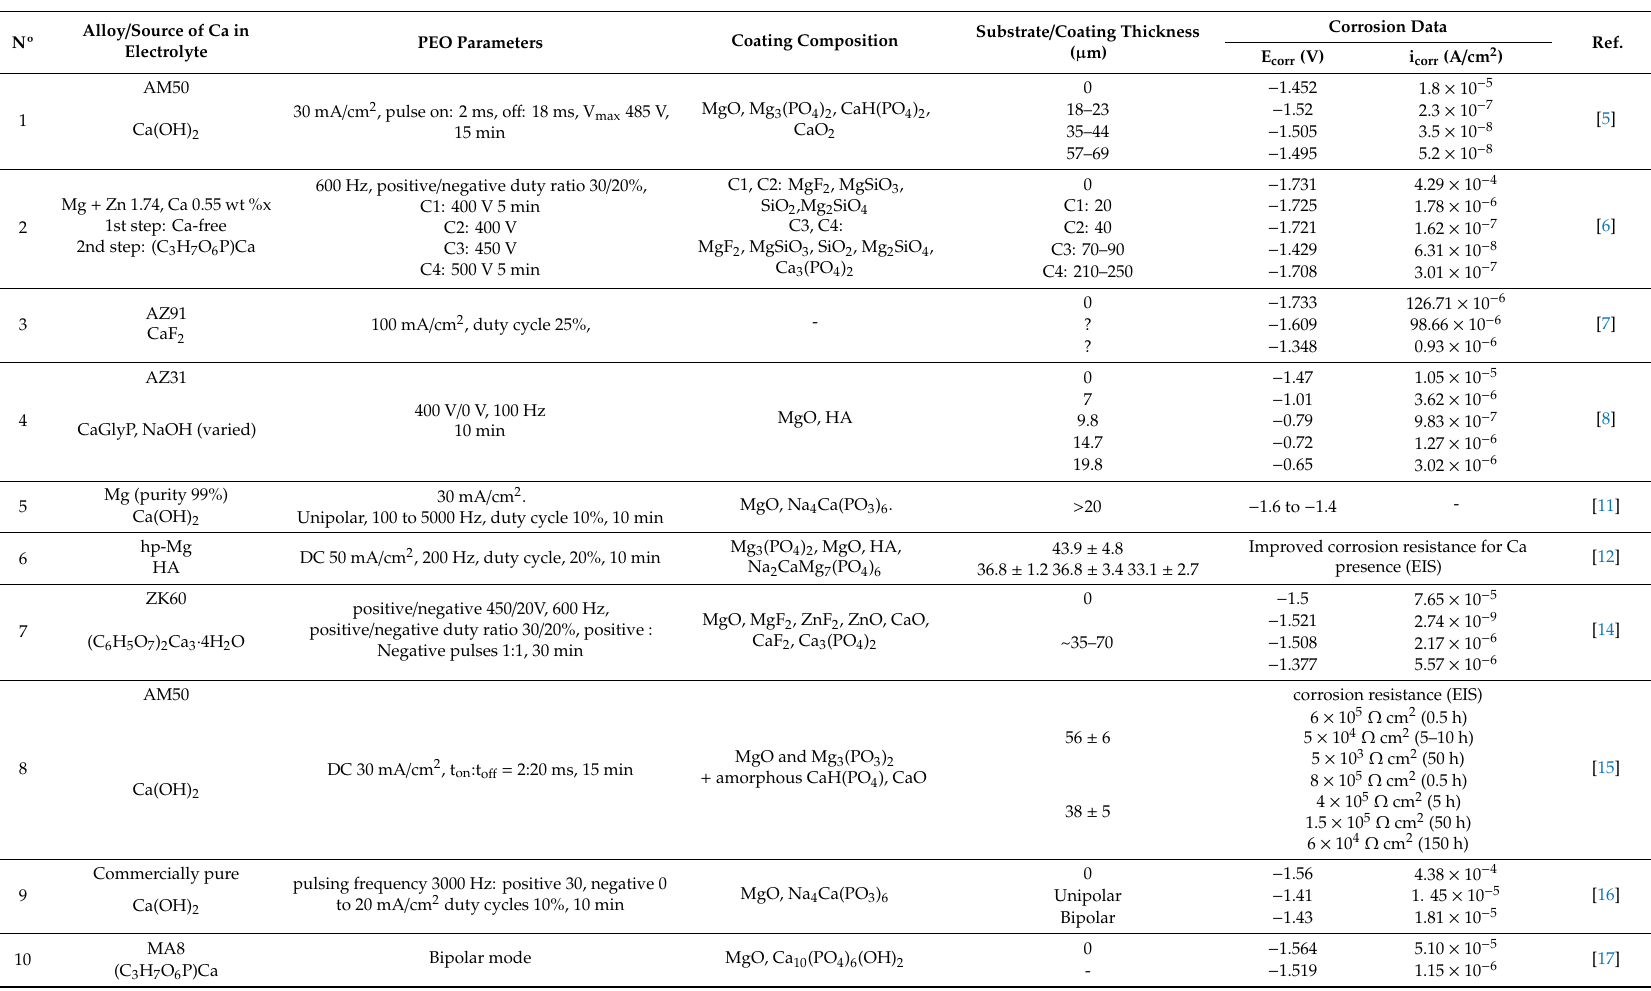
Table 1. Plasma electrolytic oxidation (PEO) treatment conditions for the Mg alloys and the properties of the resulted coatings obtained from Ca-containing electrolytes. Alloy / Source of Ca in Nº Electrolyte PEO